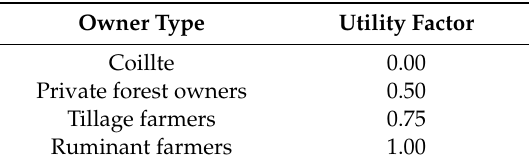
Table 6. Forest owner type specific utility factors applied to the recreation ES in the objective function of the Goal Programming (GP)